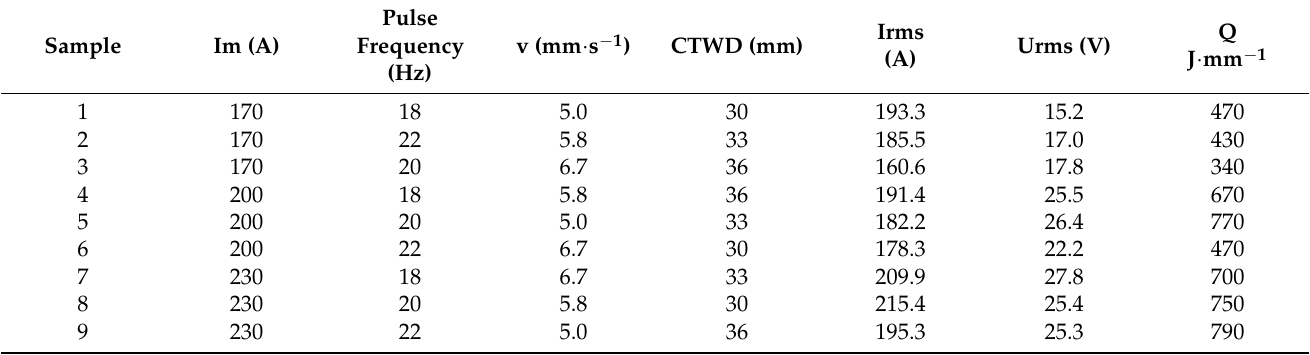
Table 2. L9 Orthogonal array of the input